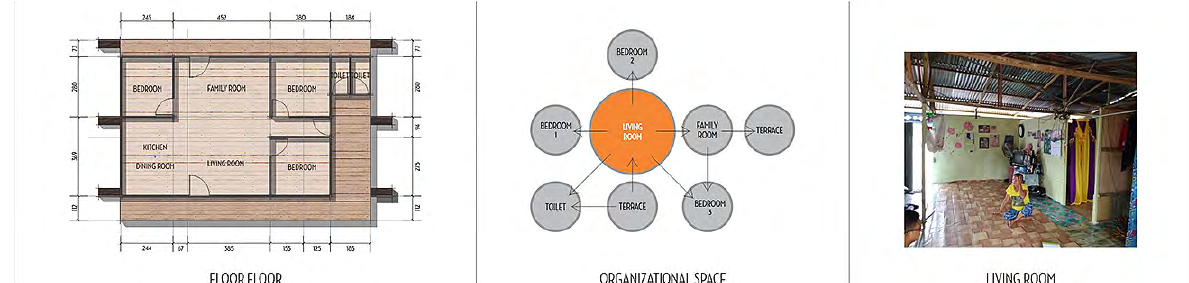
Figure 10. (a) Floor plan case 2; (b) Organizational space case 2; (c) Living room case 2